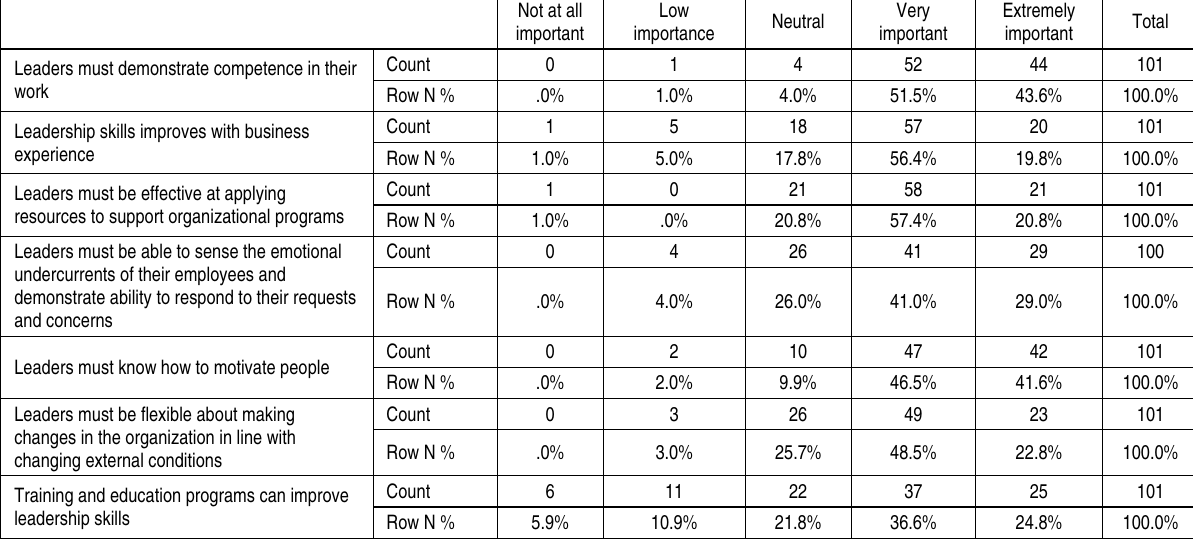
Table 2. The skill of creativity and innovation – level of importance